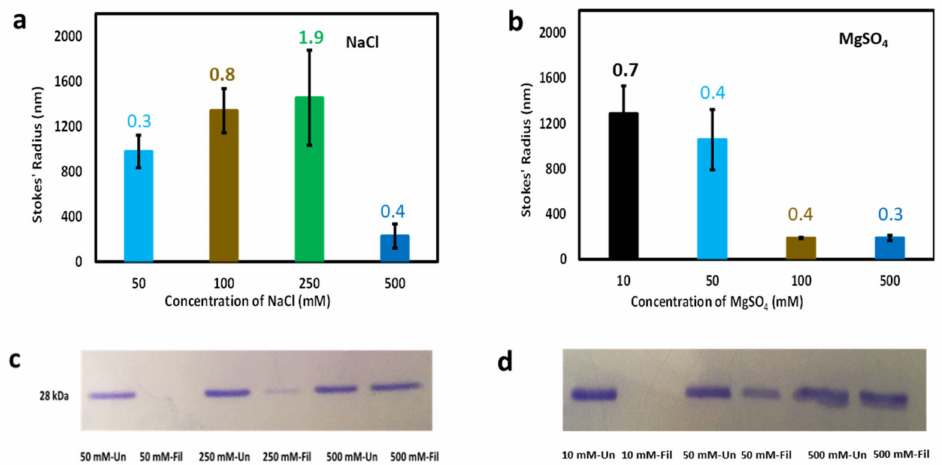
Figure 3. Particle size analysis of cl-Par-4 as a function of salt concentration. ( a ) dynamic light scattering (DLS)-derived Stokes’ radii vs. NaCl concentration. ( b ) DLS-derived Stokes’ radii vs. MgSO 4 concentration. ( c ) SDS-PAGE analysis of samples from panel ( a ), before and after filtration. ( d ) SDS-PAGE analysis of samples from panel ( b ), before and after filtration. In panels ( a ) and ( b ), error bars represent the standard deviation in Stokes’ radii from multiple runs, and the number above each bar represents the average polydispersity value for these